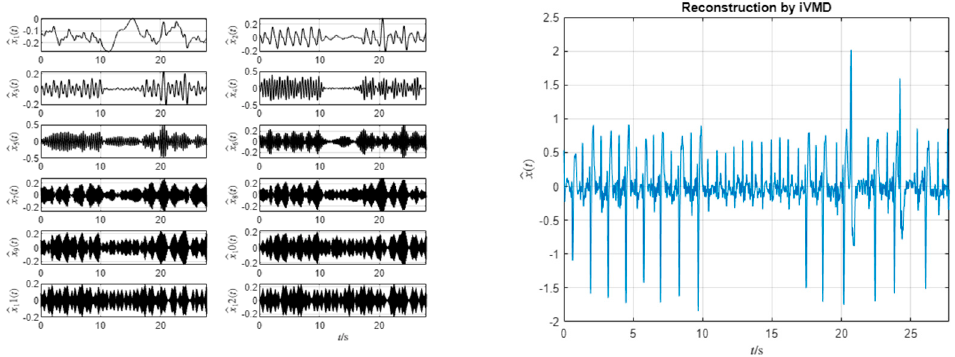
Figure 10. iVMD decomposition of x Sig5 ( t ) . We set K = 12. The left figure shows the IMFs, and the right shows the reconstructed ECG signal, where the first and last modes are discarded.